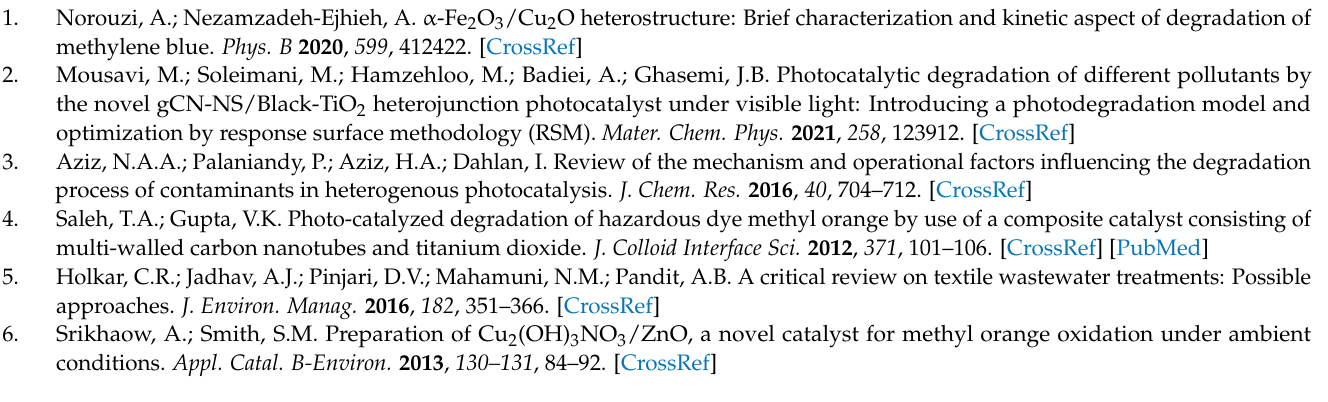
Figure S2 (a) Room-temperature EPR spectra;(b) EPFRs spectra of radical adducts in Fe/NG; Figure S3 Degradation intermediates of MB; Figure S4. Toxicological evaluation results of MB degradation intermediates; Table S1: Toxicological assessment of the MB and its